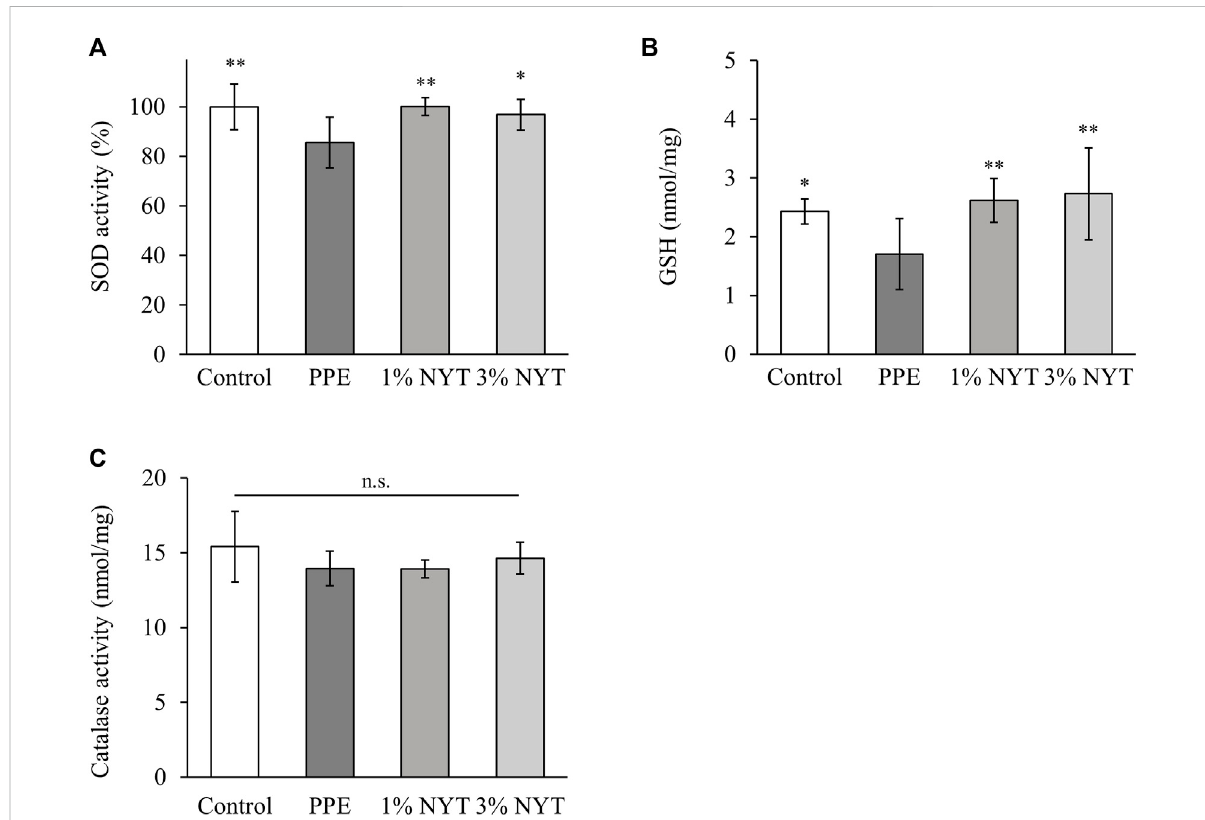
FIGURE 4 Effect of ninjin ’ yoeito (NYT) on lung tissue oxidative stress of PPE-induced COPD mice. (A) Total SOD activity, (B) level of GSH and (C) level of catalase in the lung homogenate. (Control n = 10, PPE n = 11, 1% NYT n = 8, 3% NYT n = 7). Values are expressed as means ± S.D. p p < 0.05, pp p < 0.01 vs. PPE group by Tukey